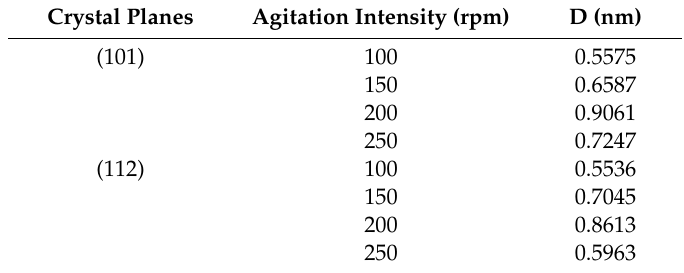
Table 3. Selectivity of crystal growth directions for NH 4 ReO 4 at di ff erent stirring